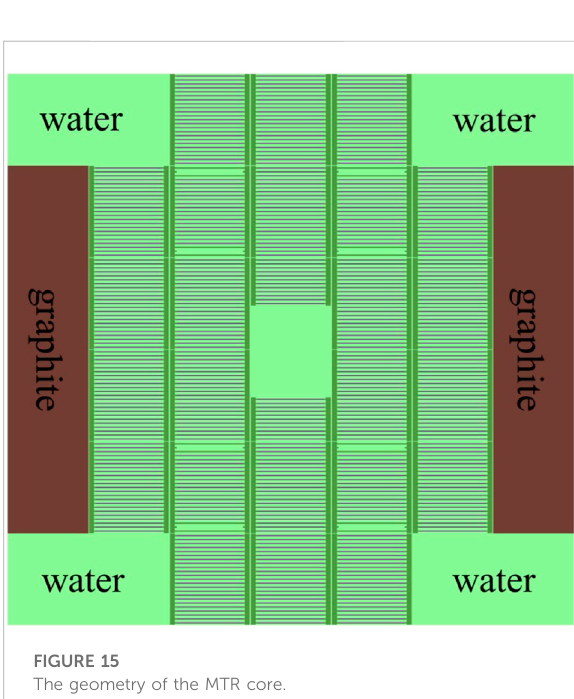
FIGURE 15 The geometry of the MTR core.